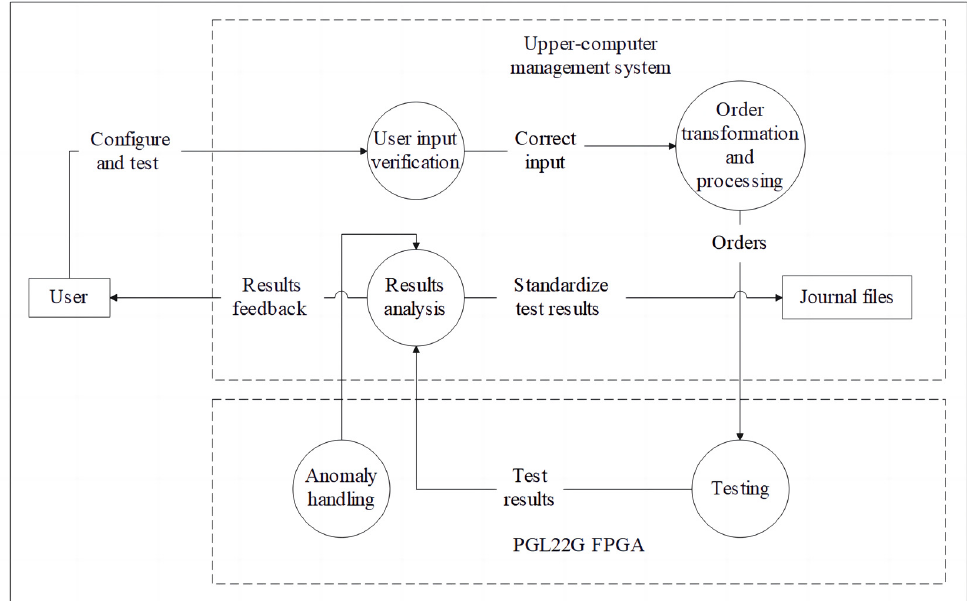
Figure 5. The structure chart of the testing system.